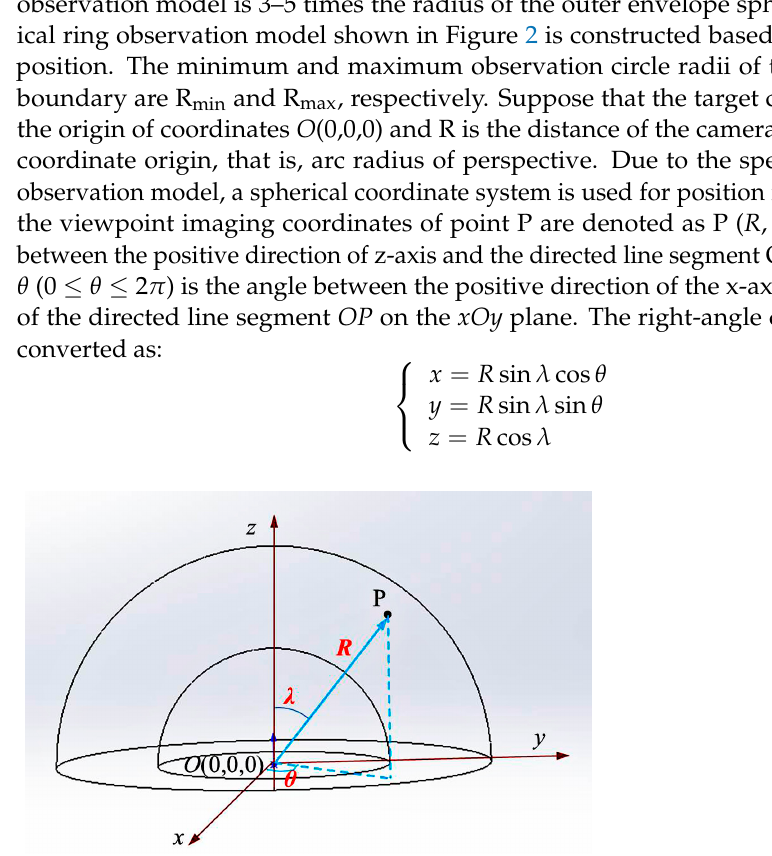
Figure 2. Geometric model of hemispherical ring observation.